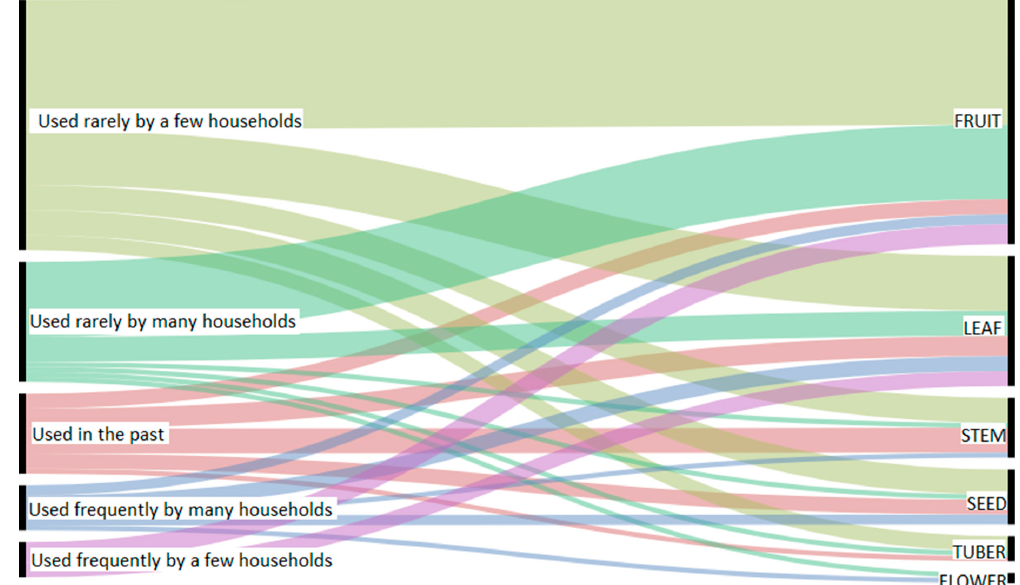
Figure 5. Plant parts used according to their extent of use (the thicker the stream, the more types of wild food